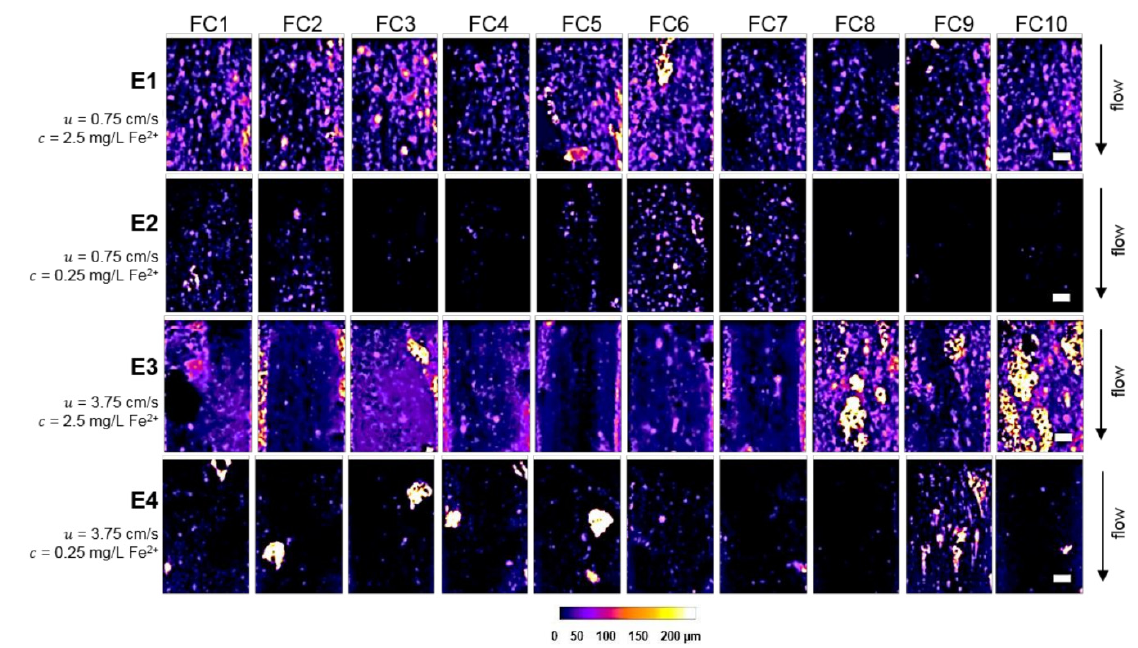
Figure 1. Biofilm height maps of day 10 comparing biofilms of each condition. The calibration bar resembles the biofilm height ( L F ) in µ m. The scale bar equals 1 mm. Experiments E1–E4 are explained in Table 1. Abbreviation FC refers to flow cell.